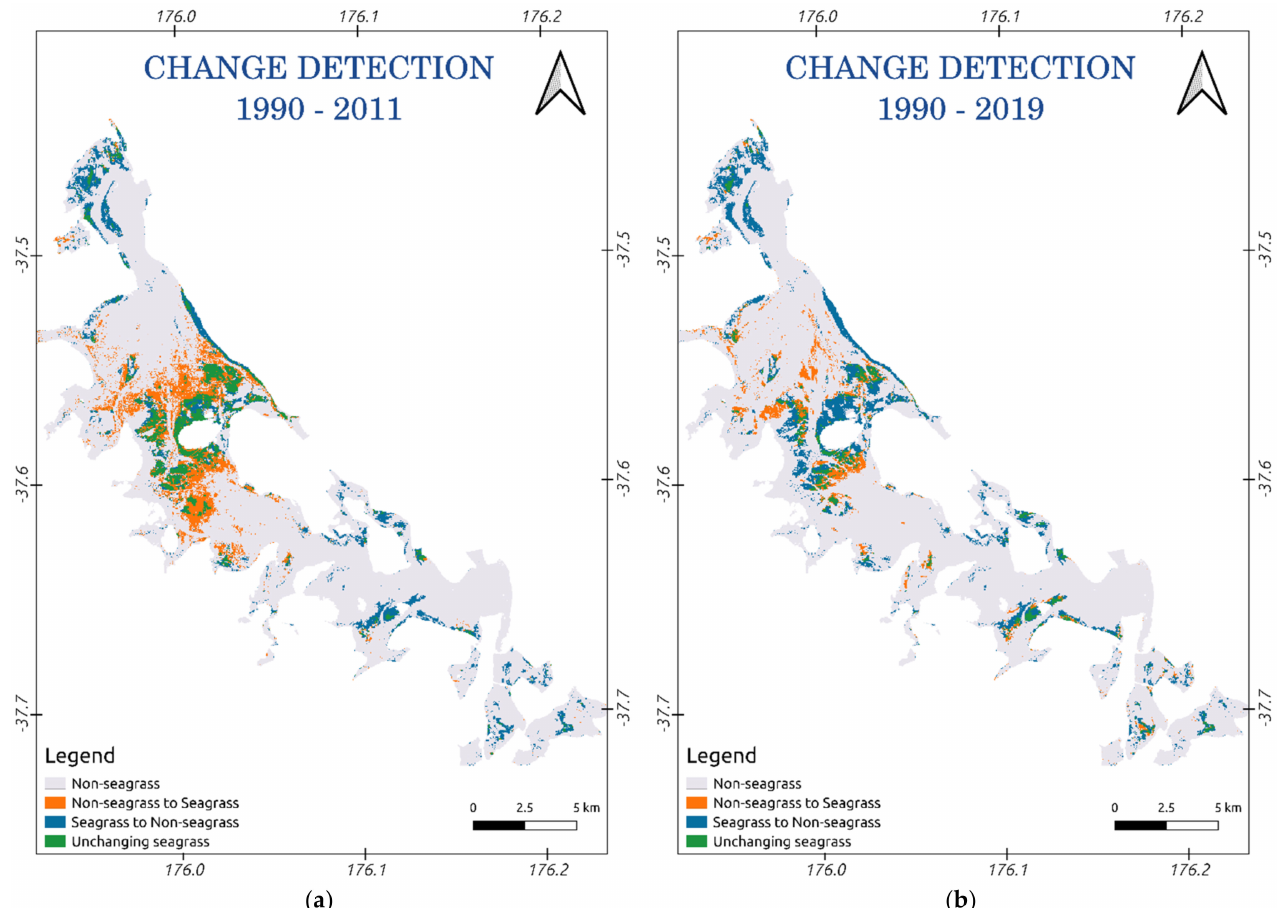
Figure 5. Seagrass change detection between 1990–2011 ( a ) and 1990–2019 ( b